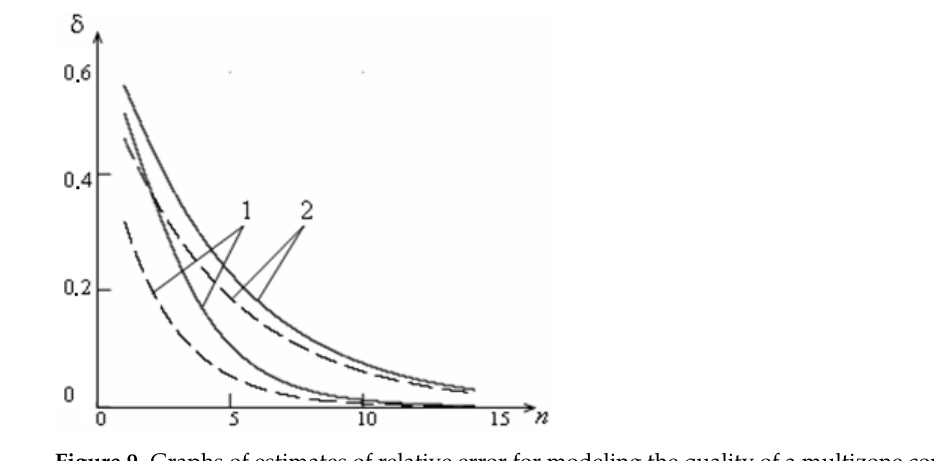
Figure 9. Graphs of estimates of relative error for modeling the quality of a multizone controller.